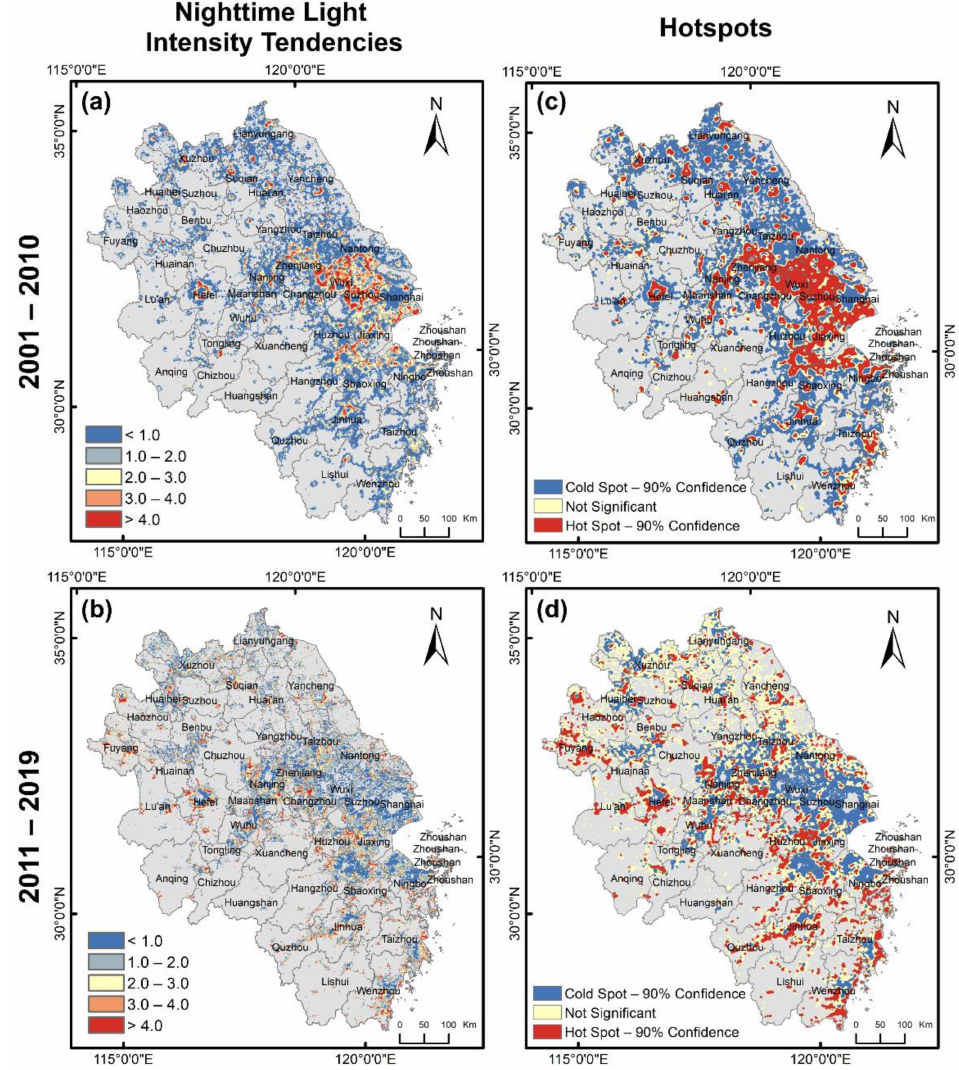
Figure 6. Tendencies and hotspot detection in 2001–2010 and in 2011–2019 over the Yangtze River Delta: ( a , b ) linear regression tendencies of the nighttime light intensity and ( c , d ) hotspot analyses from the linear regression